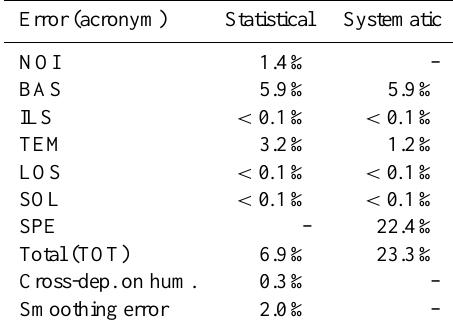
Table 4. Same as Table 3 but after applying the a posteriori operator of Eq. (14).